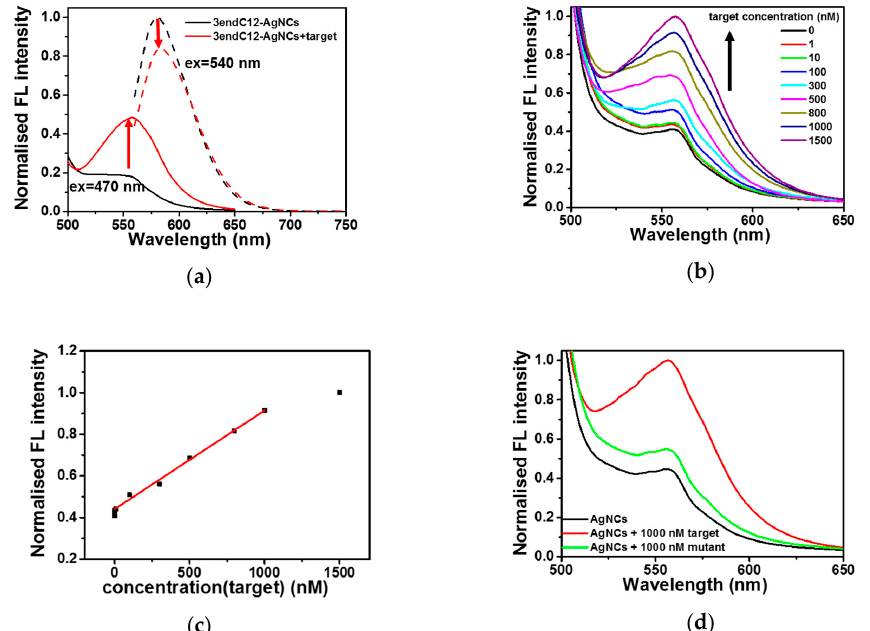
Figure 7. ( a ) The fluorescence spectra of 1 µ M 3endC12-templated Ag nanoclusters (NCs) excited at 470 nm (solid curve) and 540 nm (dashed curve) at 25 ◦ C in the absence (black) and presence (red) of 1 µ M target in 1.0 M choline dihydrogen phosphate (dhp) (pH 7.0). ( b ) The fluorescence spectra of 3endC12-Ag NCs excited at 470 nm at 25 ◦ C at different concentrations of the target. ( c ) The relation between fluorescence emission intensity at 557 nm after 470 nm excitation at 25 ◦ C with the concentration of the target. ( d ) The fluorescence spectra of 3endC12-Ag NCs excited at 470 nm and 25 ◦ C in the absence or presence of 1000 nM target or